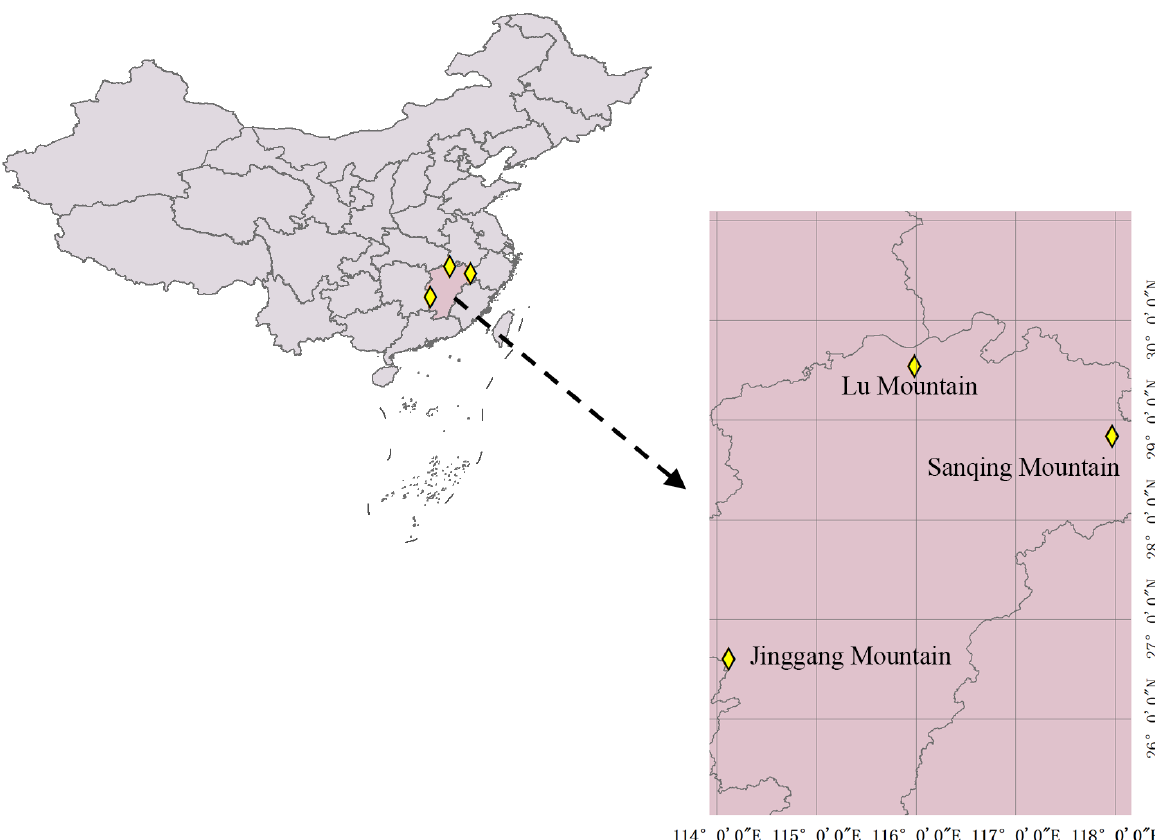
Figure 1. Distribution of sampling sites in Jiangxi Province, China.